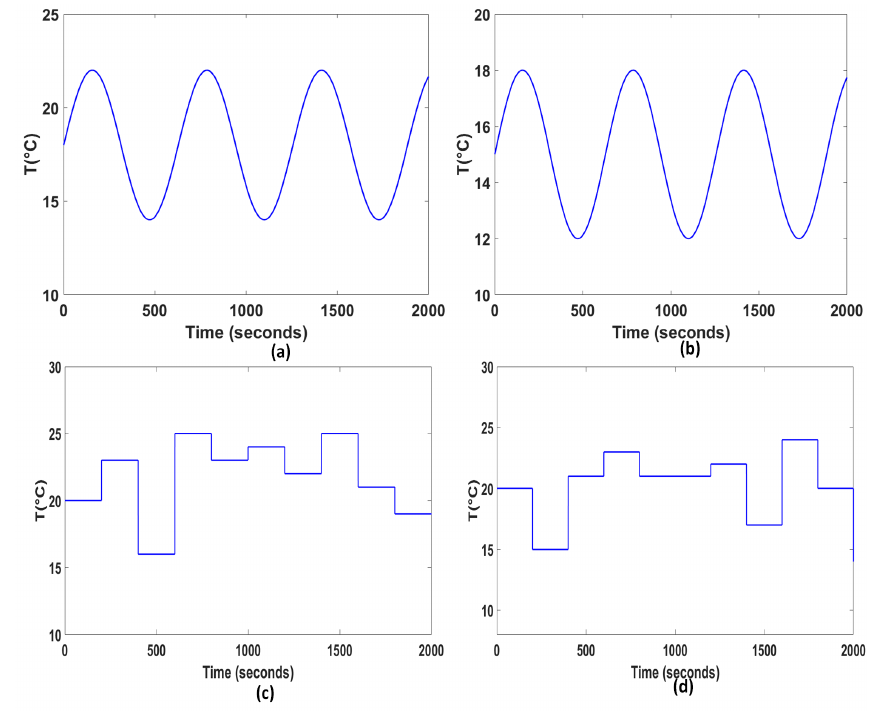
Figure 5. Setpoint temperature range for ( a ) Zone 1 sine wave reference, ( b ) Zone 2 sine wave reference, ( c ) Zone 1 reference signal having the sequence of steps and ( d ) Zone 2 reference signal having the sequence of